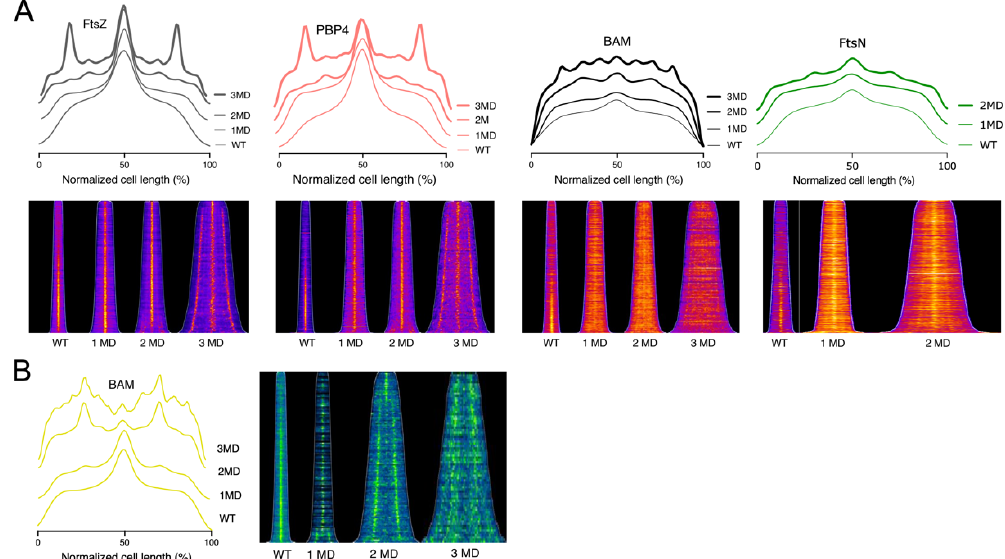
Figure 7. Localization of FtsZ, PBP4 and the BAM complex in LMC500 E. coli wild type cells treated with the PBP3 inhibitor aztreonam and in a thermosensitive PBP3 mutant. ( A ) The cells were grown to steady state in GB1 at 28 ° C (WT) or diluted in prewarmed medium and incubated with aztreonam for 1, 2 and 3 mass doublings (1–3 MD), before harvesting and immunolabelling with antibodies against FtsZ, PBP4 BAM and FtsN. The fluorescence average profiles and the corresponding fluorescence demographic maps are shown in the top panel and lower panel, respectively. FtsZ, PBP4 and FtsN reflect the divisome stalling at 25, 50 and 75% of the cell length of the by aztreonam created filaments. The BAM complex follows the divisome localization, albeit with lower intensity. Numbers of cells analyzed were for α FtsZ 5047, 1433, 858 and 660 for WT, 1MD, 2MD and 3MD, respectively. Numbers of cells analyzed were for α PBP4 2347, 1856, 1638 and 615 for WT, 1MD, 2MD and 3MD, respectively. Number of cells analyzed were for α BAM 3036, 1980, 1160 and 747 for WT, 1MD, 2MD and 3MD, respectively. Number of cells analyzed were for α FtsN 984, 711 and 610 for WT, 1MD, and 2MD, respectively. ( B ) The average fluorescence profiles of BAM in a PBP3ts mutant at permissive condition at 28 °C (WT), and at non-permissive condition at 42 °C for 1, 2 and 3 mass doubling (1, 2 and 3 MD). The BAM complex localizes at midcell, and at the future sites of constriction at 25% and 75% of the cell length. The corresponding fluorescence demographic maps of the immunolabelled BAM complex in these cells are shown on the right. Number of cells analyzed were 2378, 532, 529 and 193 for WT, 1MD, 2MD and 3 MD, respectively .